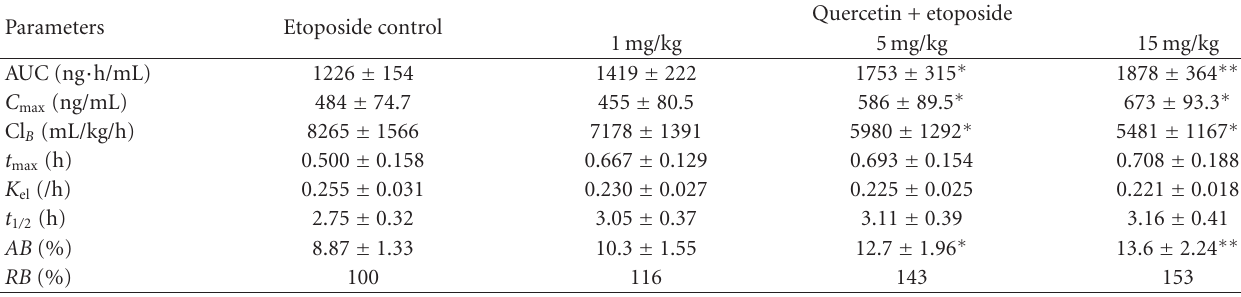
Table 32: Pharmacokinetic parameters of doxorubicin (50mg/kg) and in the presence or absence (control) of quercetin (0.6, 3, and 15mg/kg) after oral administration [215]. Parameters Doxorubicin (control) AUC 0– ∞ (ng · h/mL) 186 ±